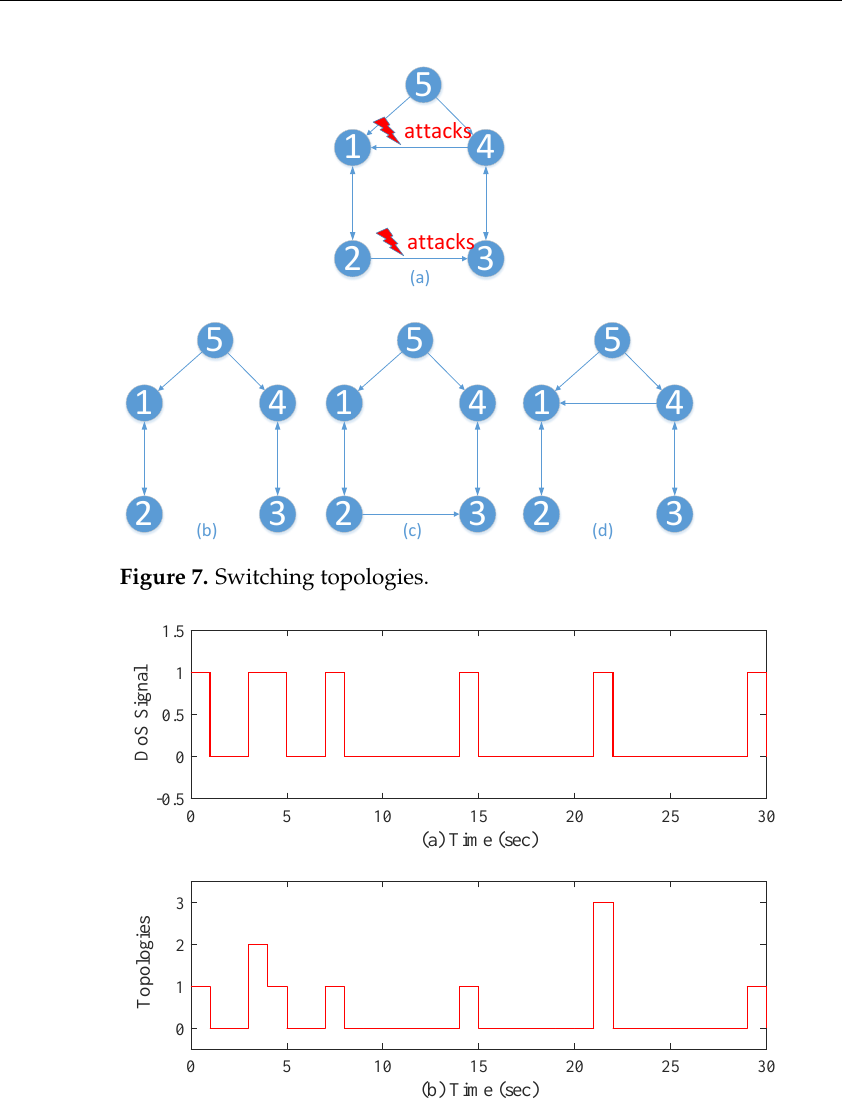
Figure 8. DoS signal and switching signal.